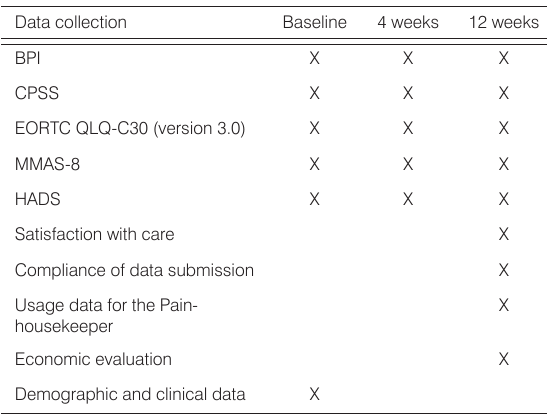
Table 2. Data collection schedule: the table depicts the schedule for data